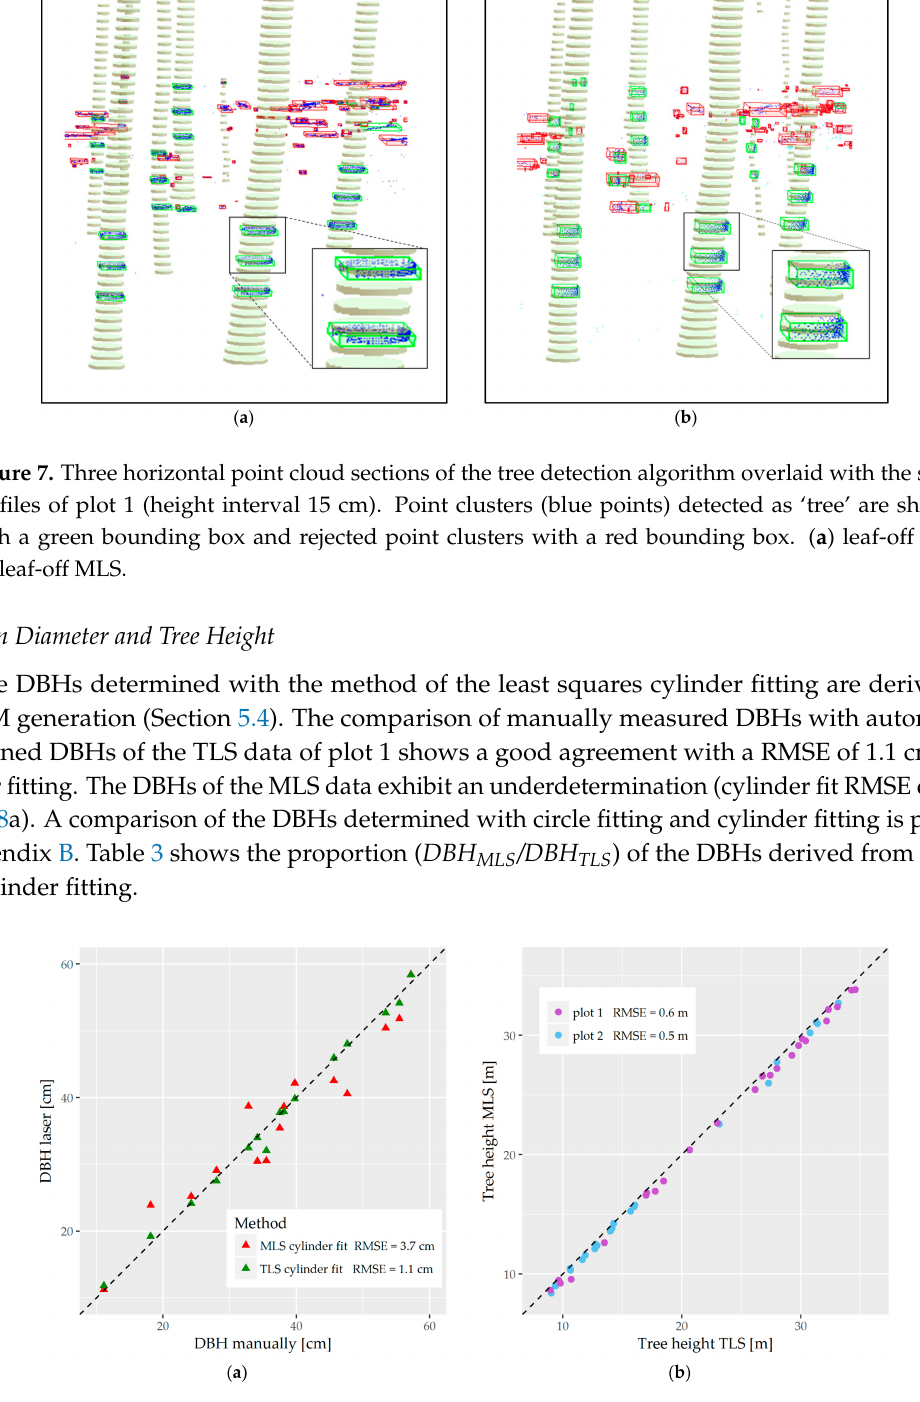
Figure 8. ( a ) DBH determination using the MLS and TLS data in comparison with the manually measured diameters; ( b ) Tree height estimation of the MLS and TLS